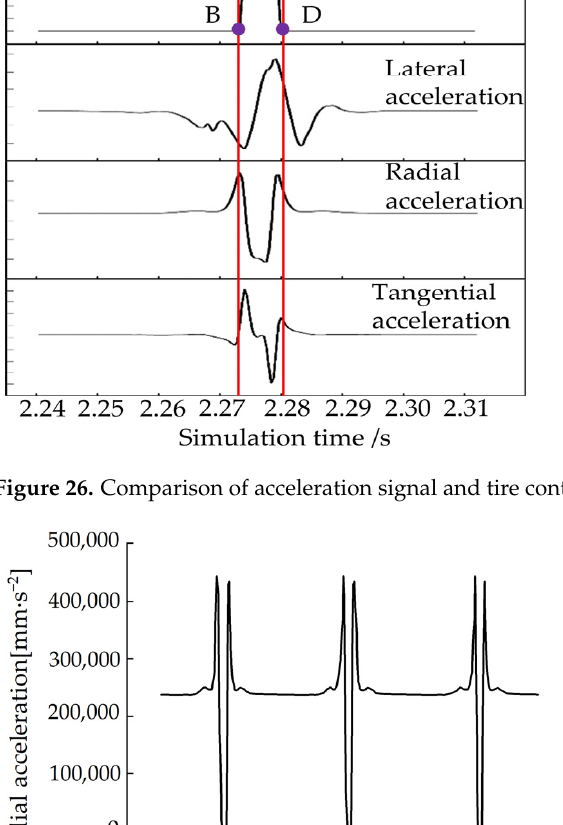
Figure 28. Verification results of the longitudinal estimation of the tire contact patch length.